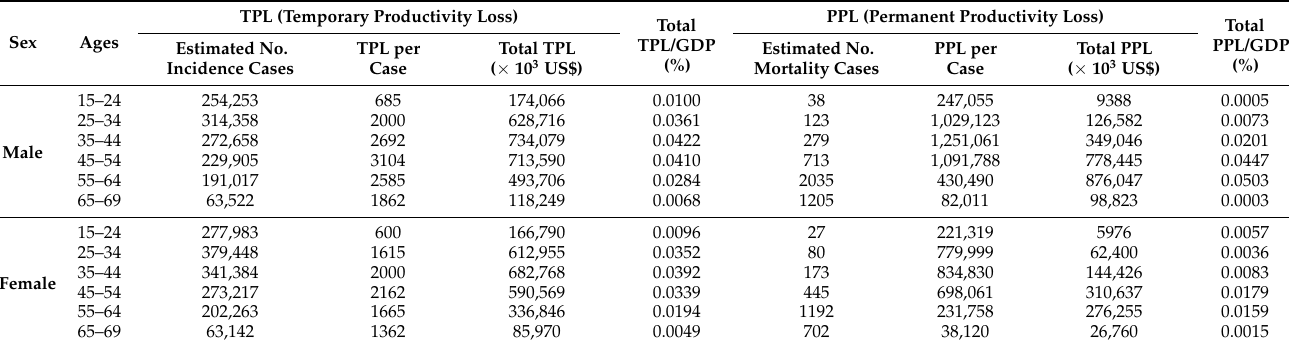
Table 4. Estimated temporary and permanent productivity losses (TPL and PPL) at different ages in Canada from February 2020 to Apr. 2022 based on the 2019 GDP (gross domestic